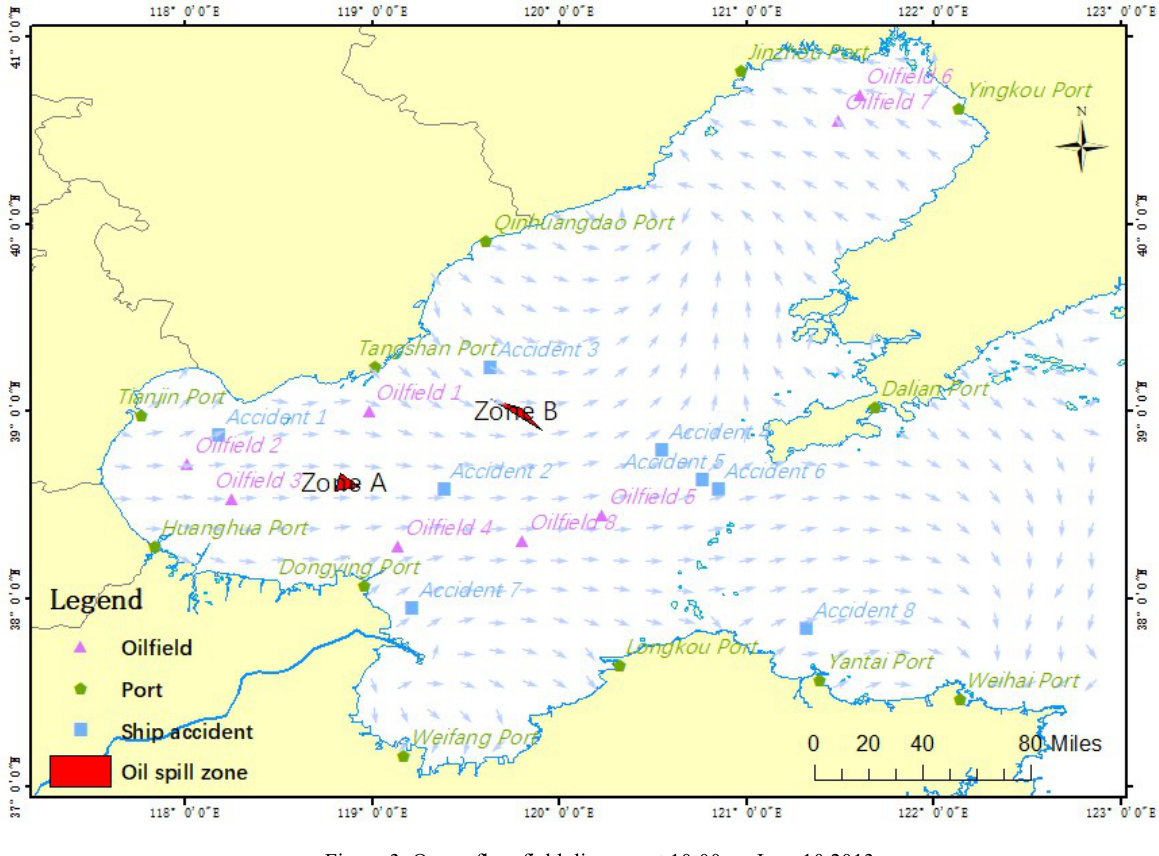
Figure 3. Ocean flow field diagram at 10:00 on June 10,2013